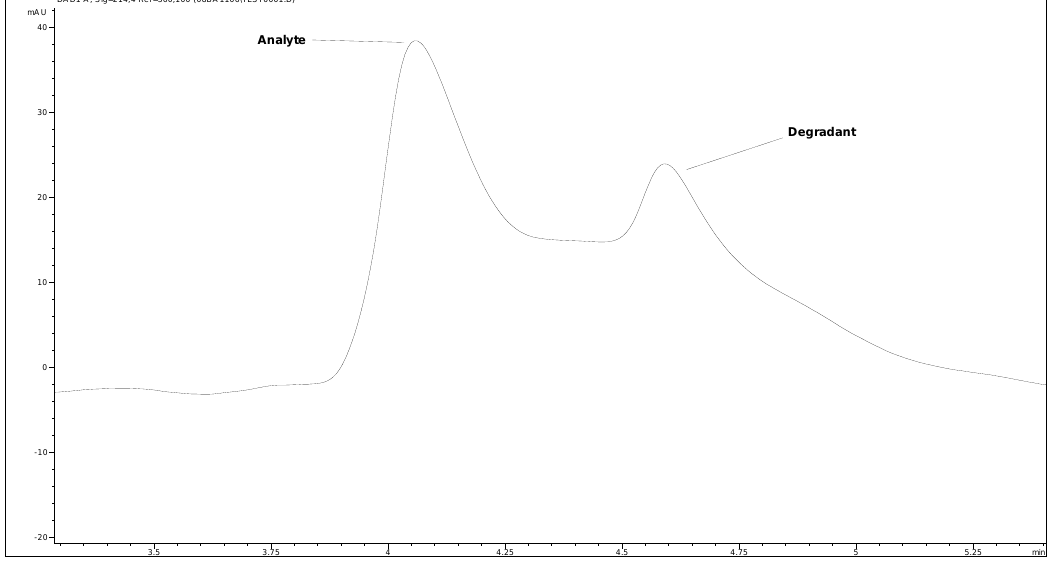
Figure 2. An example chromatogram of a nonstability-indicating HPLC method that evaluates the analyte and degradant sample peaks.